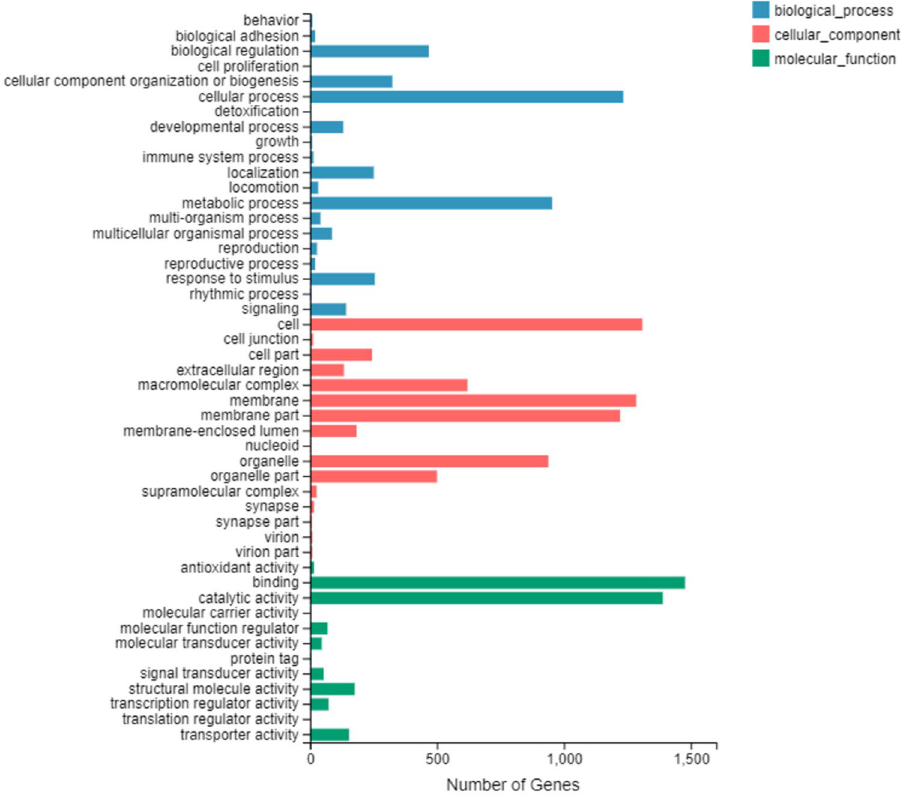
Figure 3. Gene ontology (GO) classification of differentially expressed genes. The X-axis indicates the number of unigenes in each category. The Y-axis represents three main ontologies: biological process, cellular component, and molecular